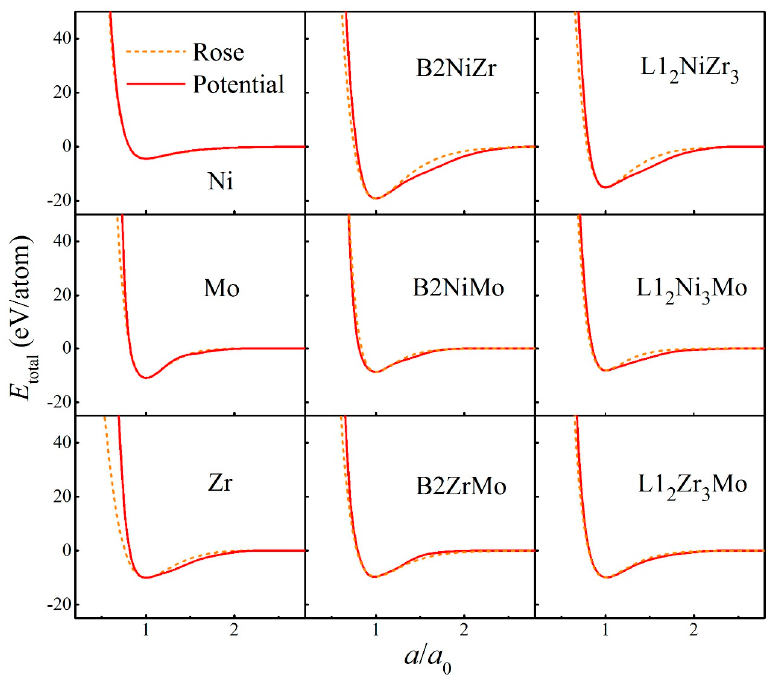
Figure 2. Total energies calculated from interatomic potential ( Red solid line ) and corresponding Rose equation [65] ( Orange dashed line ) as a function of lattice constant for pure metals as well as B2 and L1 2 compounds in the Ni-Zr-Mo system.